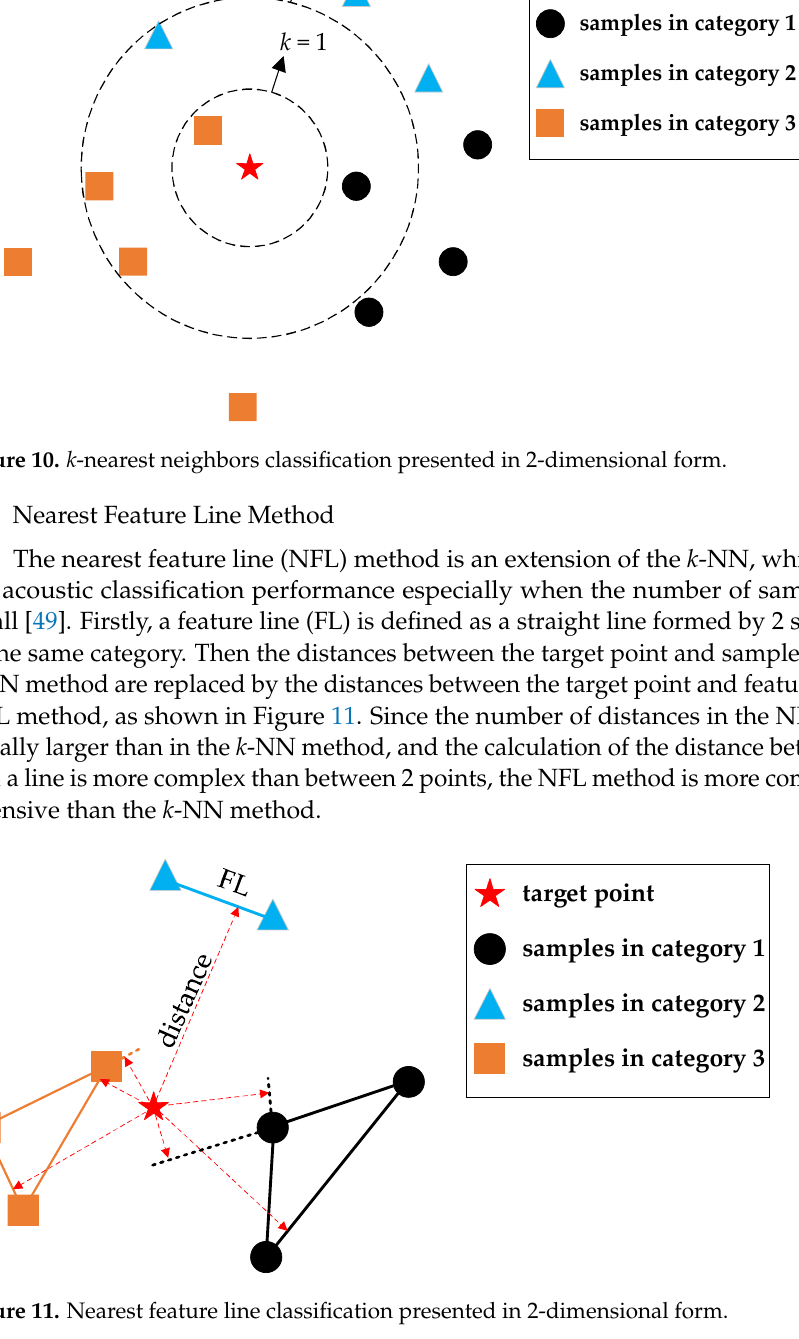
n-feature classification Figure 9. Threshold-based classification. 